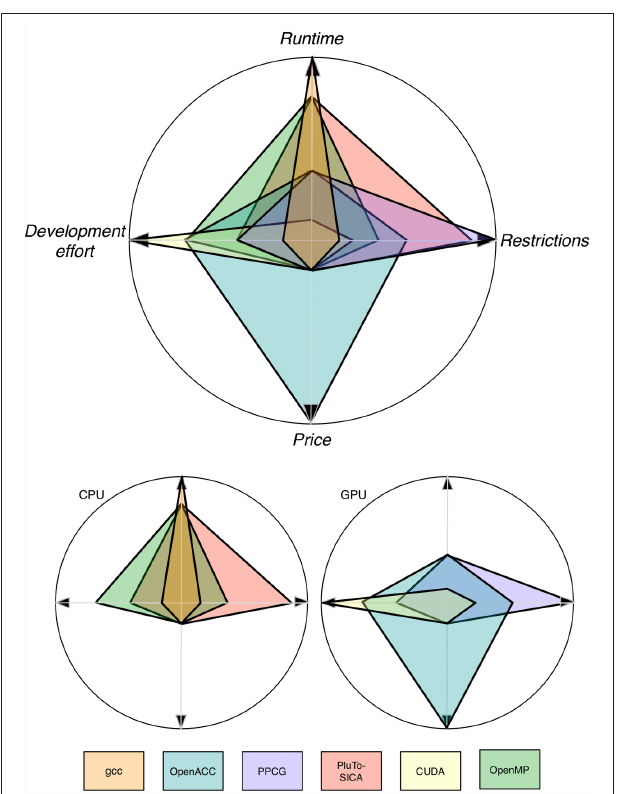
FIGURE 10 | Trends for four categories depicting the pros and cons of different optimization techniques. Note that these values are only trends and the depicted values are problem dependent. Note that the runtime axis is scaled